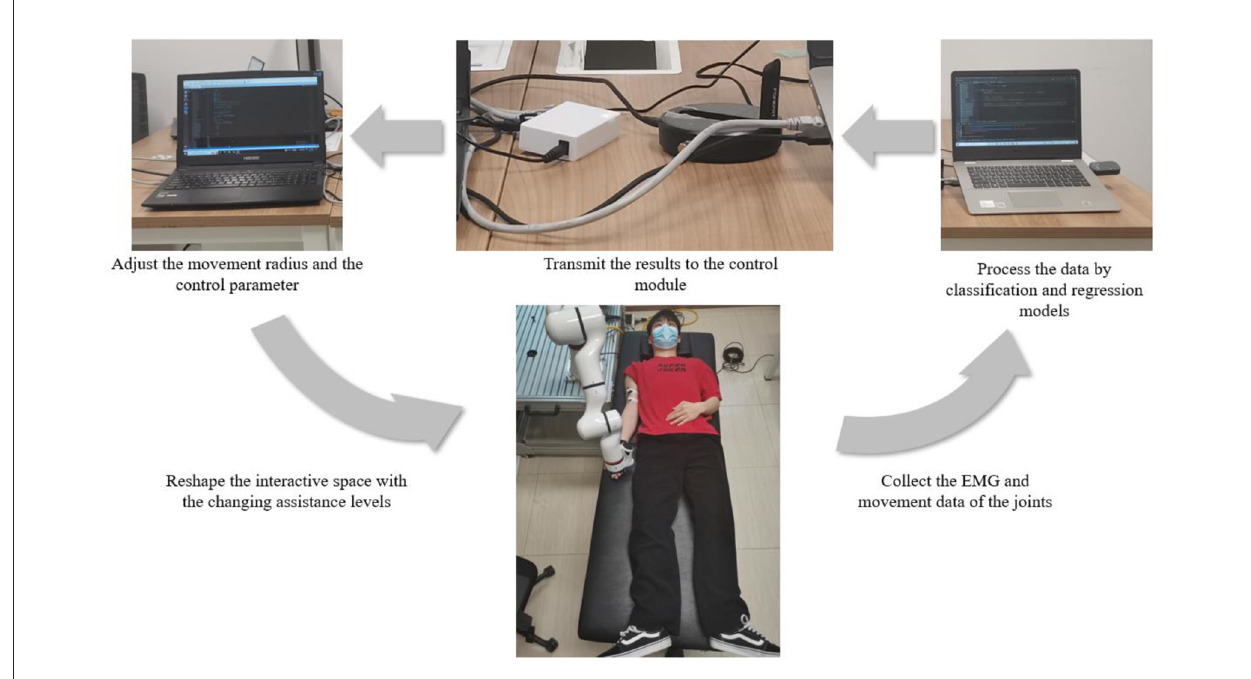
FIGURE3 The working process of the online experiment.